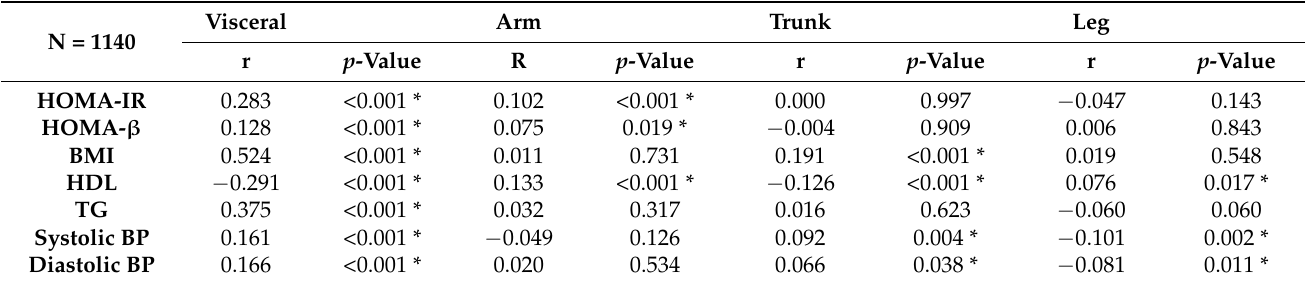
Table 10. Associations between regional adiposity and metabolic characteristics in non-medicated participants. N =